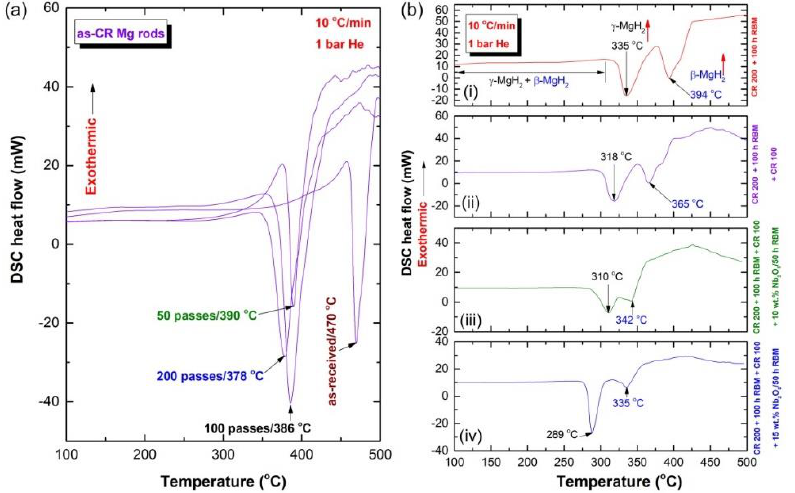
Figure 7. DSC thermograms obtained with 10 °C/min under He atmospheric pressure for ( a ) as-CR Mg rods after processing for 0, 50, 100, and 200 passes and then hydrogenated under 50 bar of H 2 at 400 °C, and ( b -i) as-200 passes CR Mg obtained after RBM for 100 h, ( b -ii) as-200 passes +100 h + 100 CR for passes. ( b -iii) and ( b -iv) display the DSC curves of the MgH 2 powders catalyzed with 10 wt.% and 15 wt.% of Nb 2 O 5 powders, respectively.